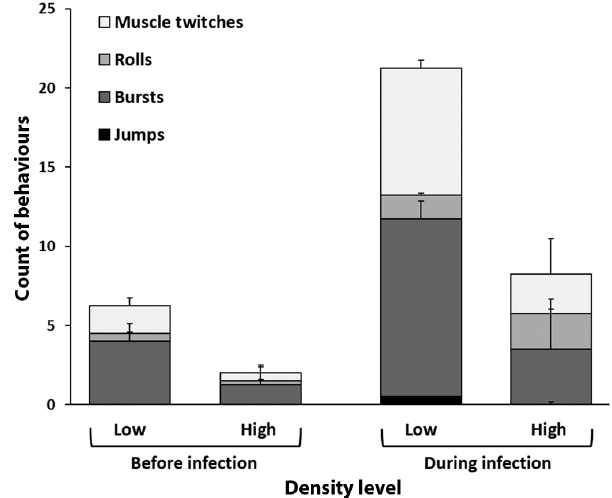
Fig. 4. Mean ± SE count of behaviours (muscle twitches, rolls, bursts, jumps) observed in salmon Salmo salar before and during infection with sea lice Lepeophtheirus salmonis copepodids at low (12 fish; 7.9 ± 1.0 kg m −3 , mean ± SE) and high (96 fish; 68.5 ± 5.8 kg m −3 ) fish